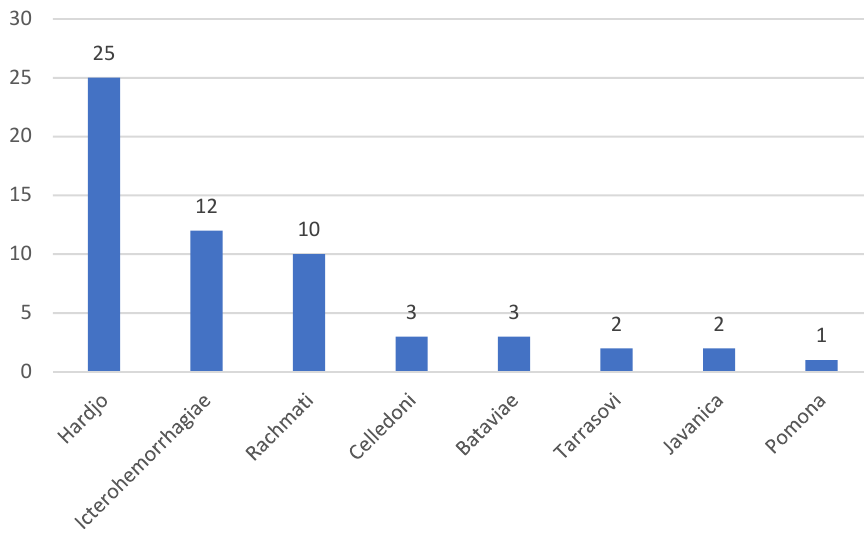
Figure 1. Number of positive cattle for each Leptospira serovar.